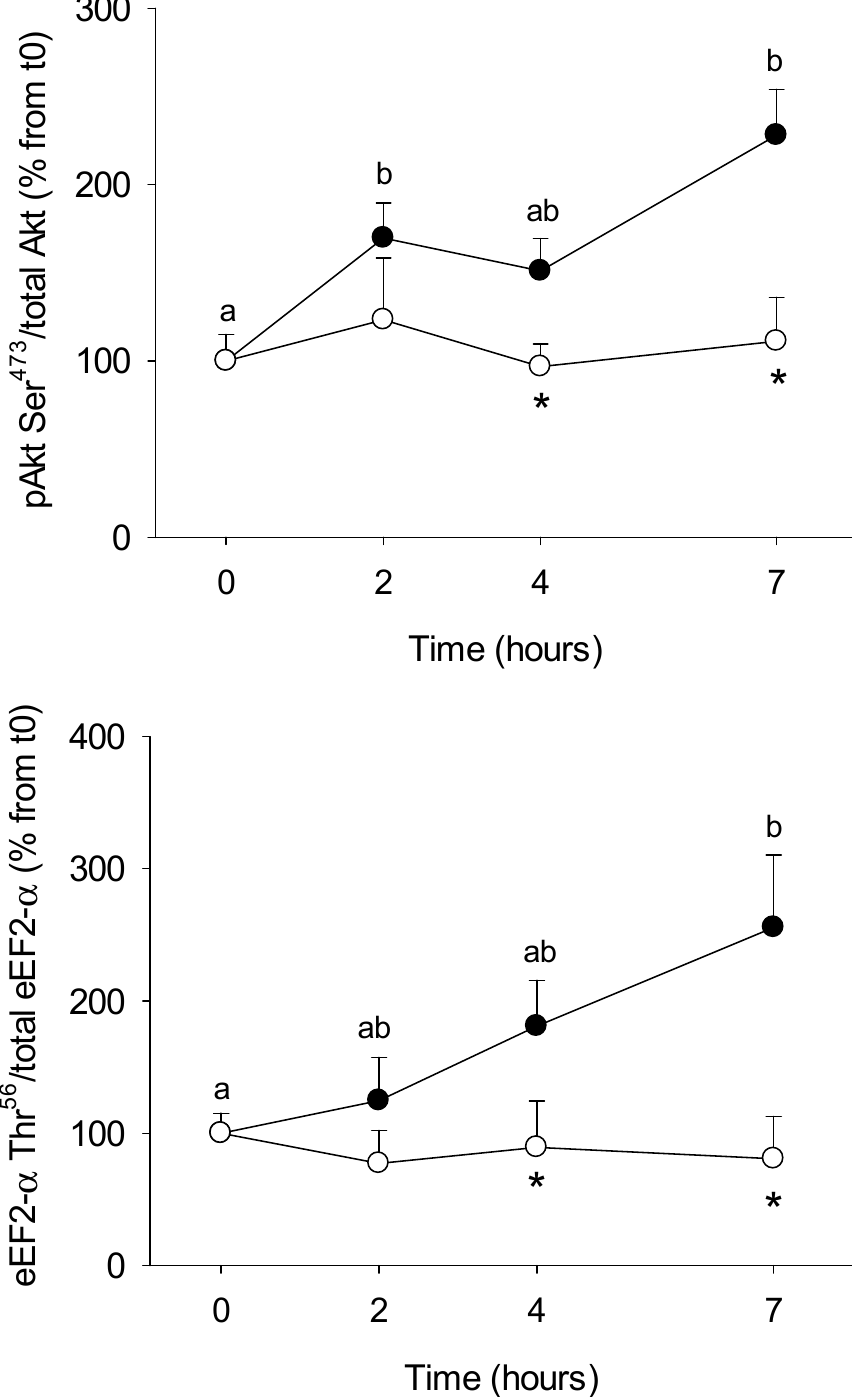
Figure 3. Phosphorylation levels of Akt Ser 473 and eEF2- α Thr 56 in PBMCs and S6 Ser 235/236 from Yucatan mini-pigs fed either a control or a high fat–high sucrose (HFHS) test meals. Analysis was made by Western blot and levels of phosphorylated protein were normalized to the levels of the respective total protein (Akt Ser473 and eEF2- α ). Results are expressed as means + SEM ( n = 5) and were analysed using a repeated measures two-way ANOVA test. Different letters indicate significant differences between sampling points for a given meal test. *Significant different for a given sampling point between the control and the HFHS meals ( p < 0.05). Table 1. Plasma fasting metabolites in Yucatan minipigs fed a high fat–high sucrose diet (HFHS) over 2 months.